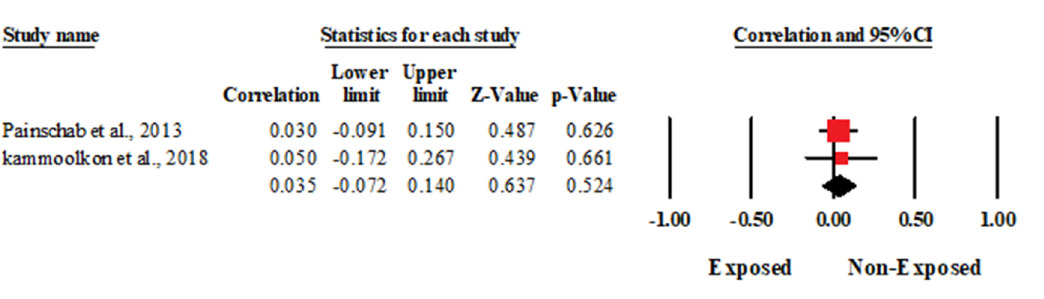
Figure 15. Forest plot of summary analysis of the correlation coefficient and 95% CI of the association between HAP and CIMT. The size of the red squares is proportional to the statistical weight of each trial. The gray diamond represents the pooled point estimate. The positioning of both diamonds and squares (along with 95% CIs) beyond the vertical line (unit value) suggests a significant outcome (IV = inverse variance).